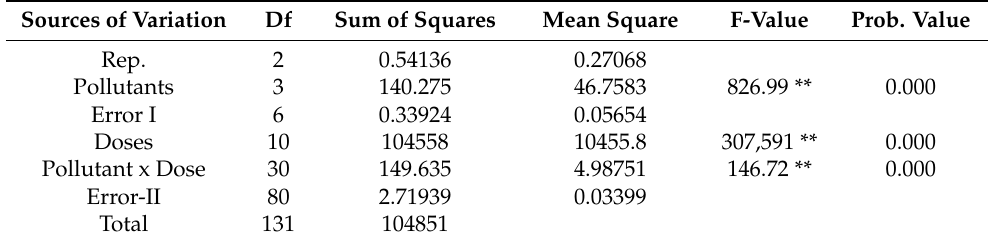
Figure 7. Effect of catalyst/adsorbent dose (TiO 2 /AC) on removal of HC (35 ◦ C temperature, pH 3, and 1 h contact time; feed volume 100 mL). Table 6. Analysis of variance for % reduction of model waste by TiO 2 /AC.